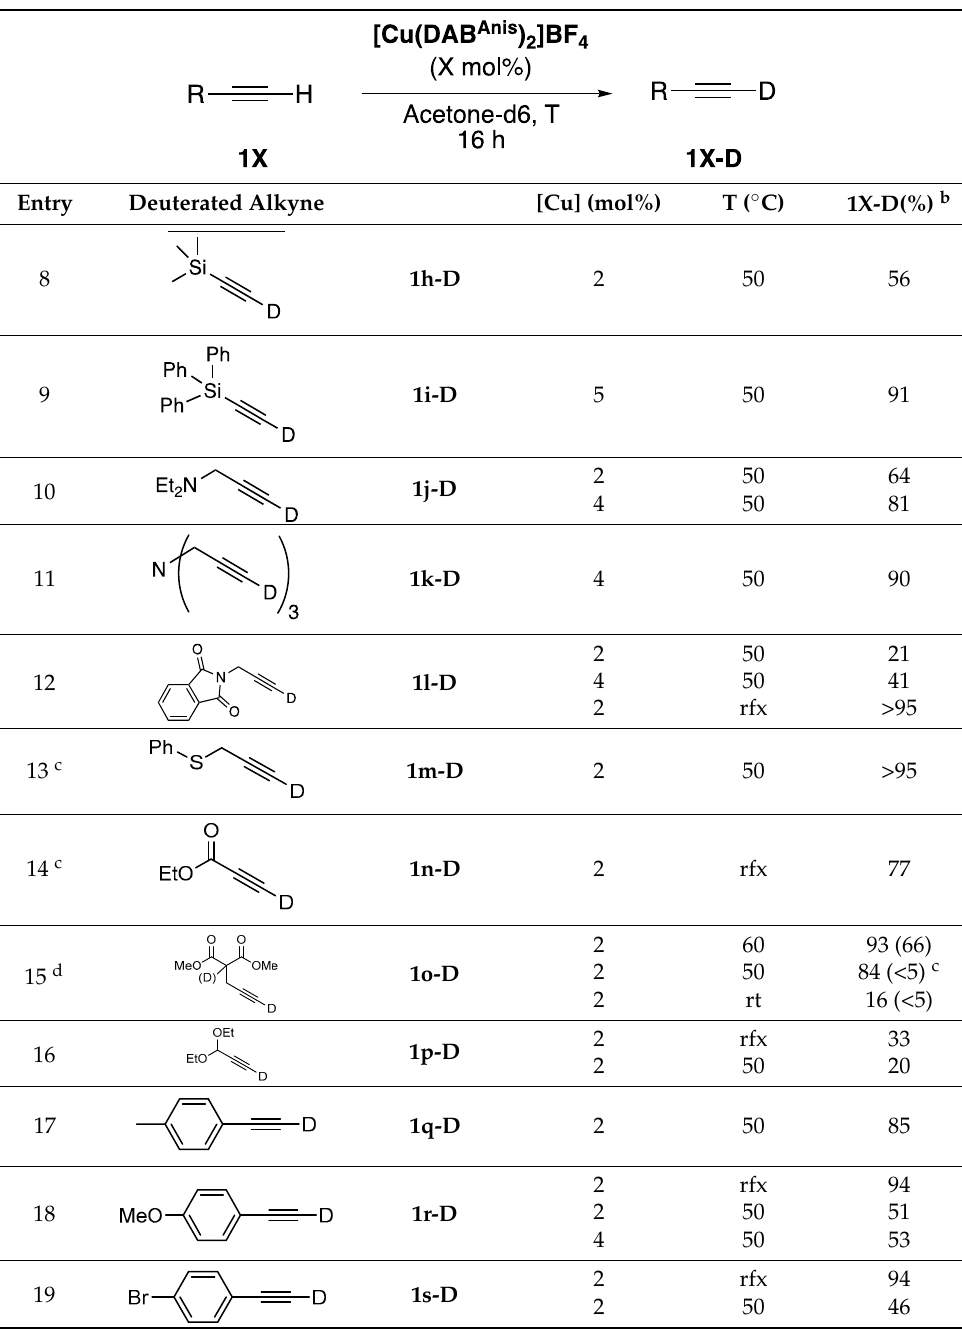
Table 3. Cont . Table 3. Scope of the reaction a .